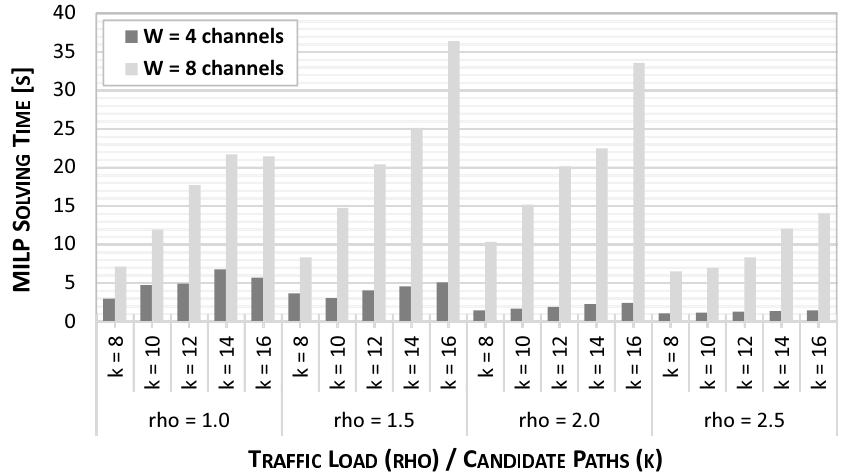
Figure 5. MILP solving times as a function of the number of candidate routing paths ( k ) and traffic load ( ρ ) in network MESH-38 assuming W ∈ { 4,8 }